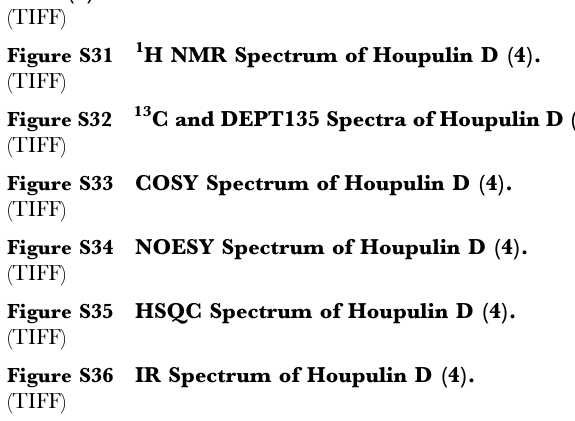
Figure S37 CD Spectrum of Houpulin D (4). (TIFF) Figure S38 Mass Spectrum of Houpulin D (4). (TIFF) Figure S39 High Resolution Mass Spectrum of Houpu- lin D (4).